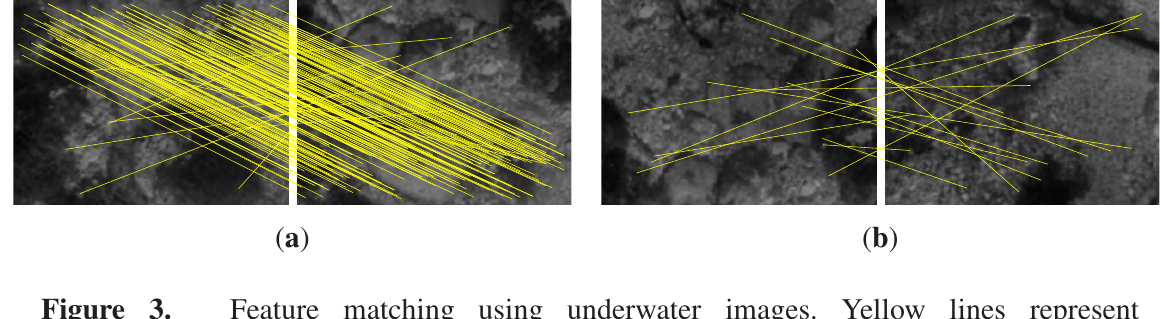
Figure 3. Feature matching using underwater images. Yellow lines represent correspondences between features. ( a ) Overlapping images; ( b ) non-overlapping